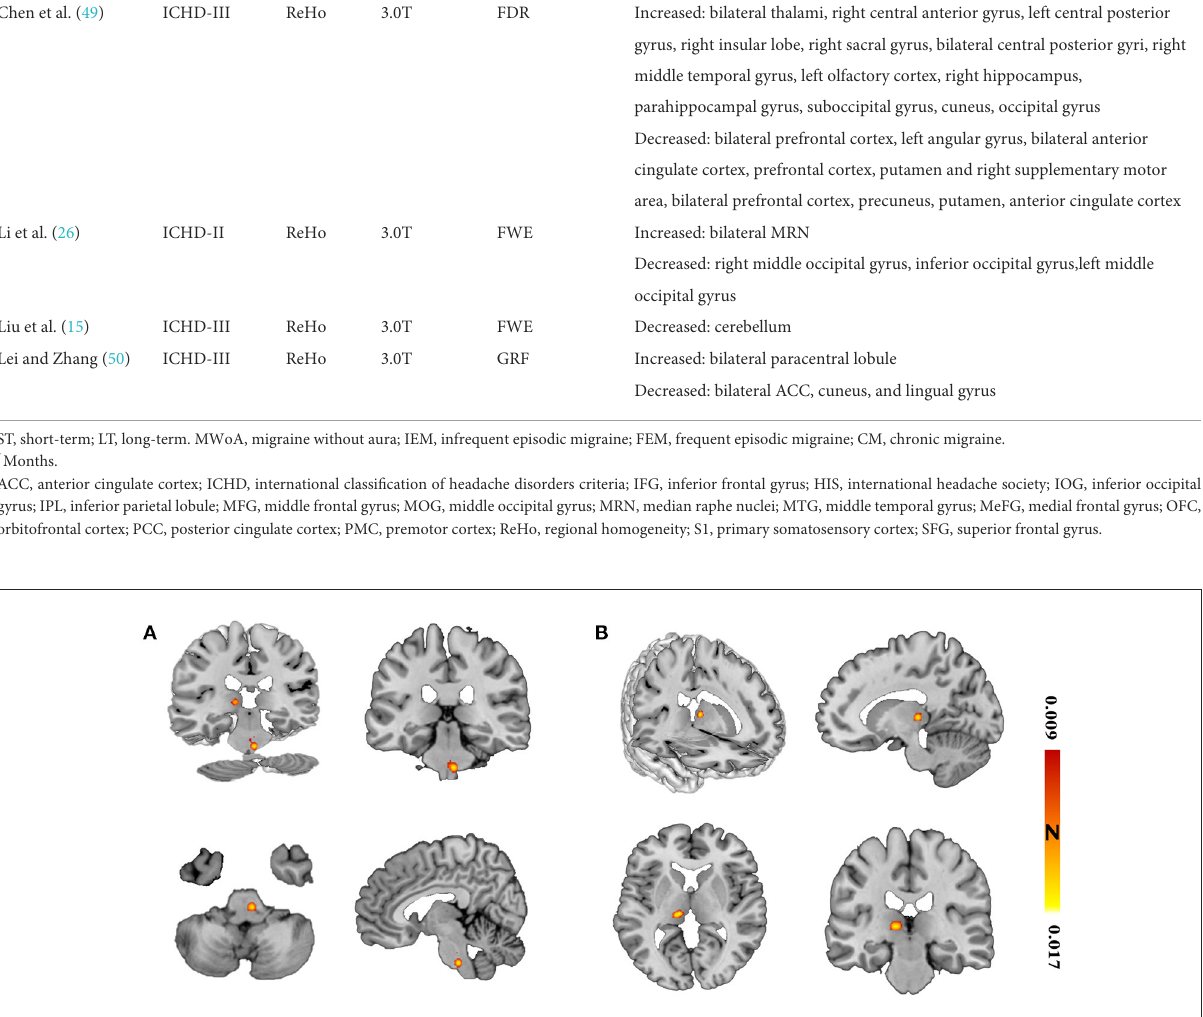
FIGURE2 The spontaneous activity of ReHo in migraine patients. Using whole-brain overview and axial, sagittal, and coronal view, (A) illustrates the brainstem activating cluster (MNI: 6, − 30, − 44, 600 mm 3 ); (B) shows the left thalamus activating cluster (MNI: − 10, − 24, 2, 560 mm 3 ).